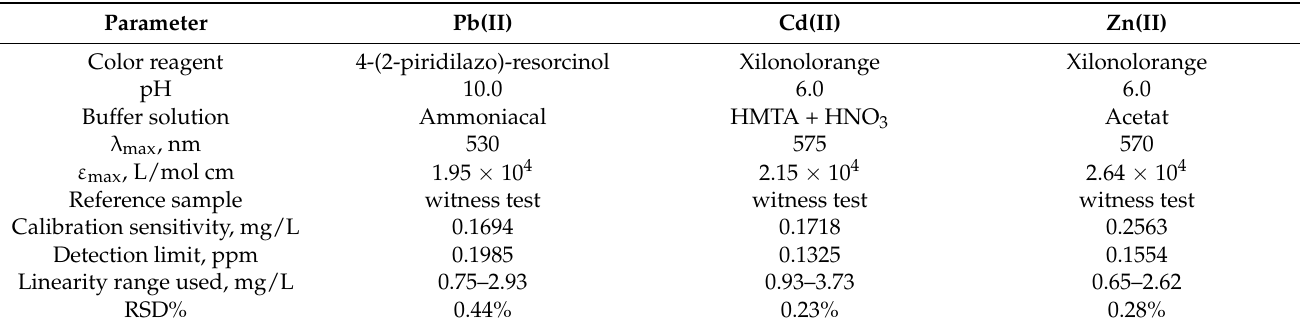
Table 1. Analytical characteristics of the spectrophotometric methods used to determine the concen- tration of metal